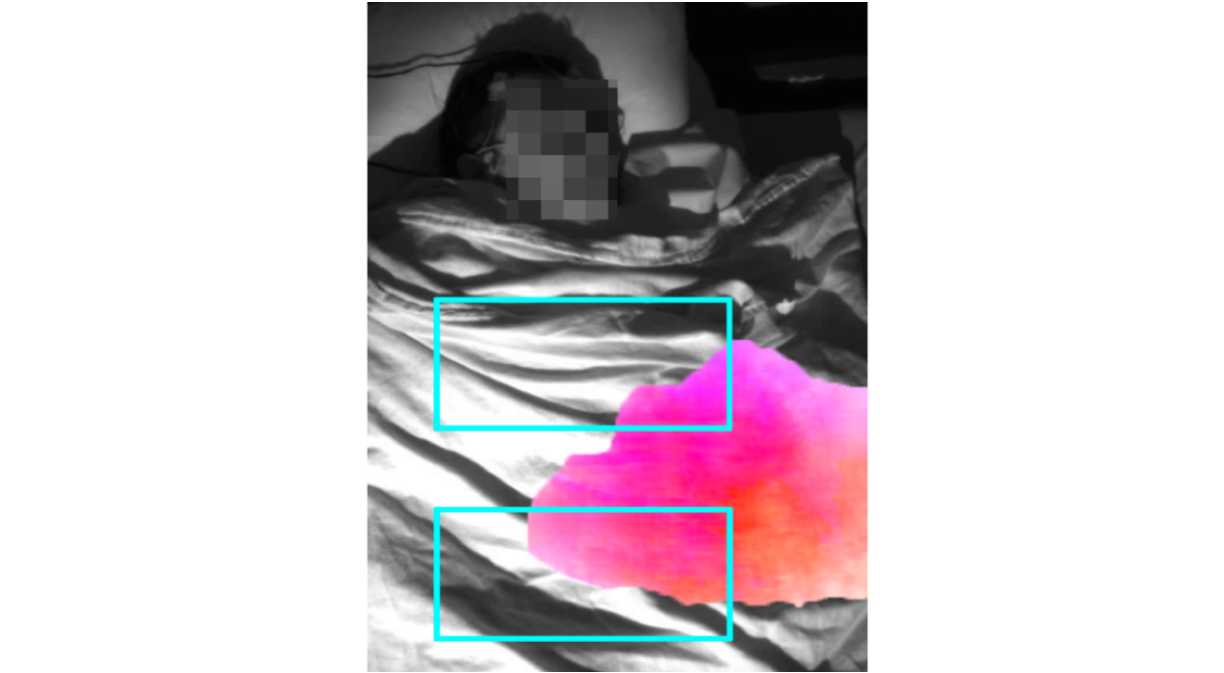
Figure 7. Annotated chest and abdomen regions do not capture a large area where most of the respiratory-related movement is visible. Manually annotated chest and abdomen regions are shown with blue boxes. Areas with large movement intensity (magnitude of the optical flow) are highlighted in